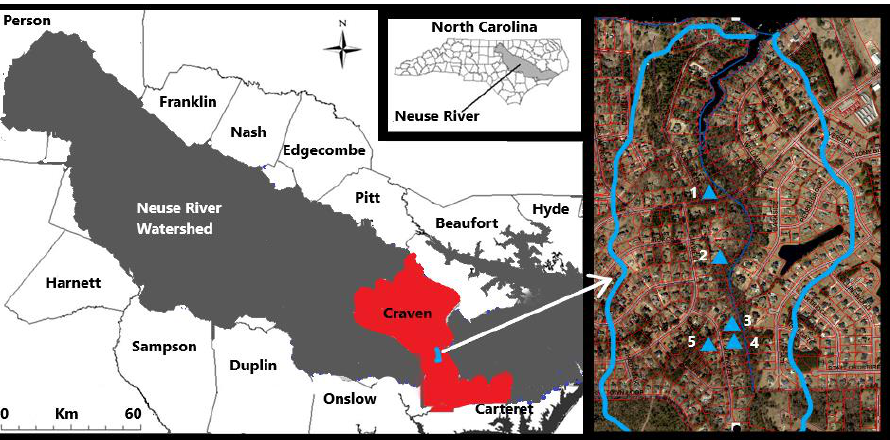
Figure 1. Study sites were located in the Hoods Creek watershed within Craven County, NC. Hoods Creek is a tributary of the Neuse River and thus within the Neuse River drainage basin. Sites 1–5 are shown as triangles in the right panel. Table 1. Characteristics of onsite wastewater systems at each of the 5 study sites.